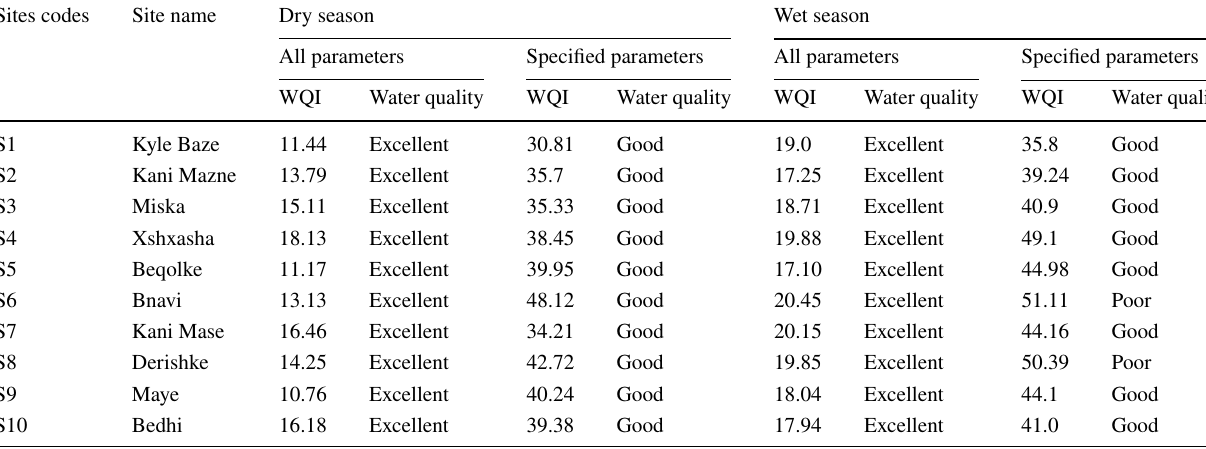
Table 9 WQI and classification for the sampled sites Sites